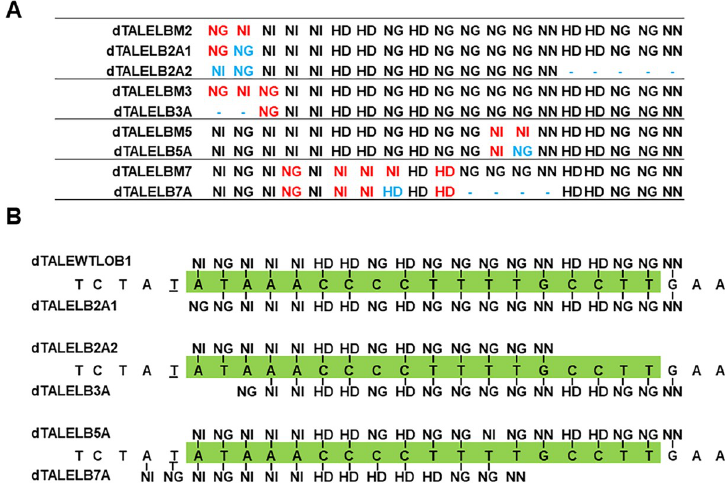
Fig 4. Repeat rearrangements in adapted dTALEs. A. RVD repeat arrays of parental and adapted dTALEs. Red- colored RVDs represent original mismatches compared to dTALEWTLOB1. Blue color indicates deleted or altered repeats in the adapted dTALEs compared to parental dTALEs. B. Predicted binding of adapted dTALEs [determined according to TAL Effector Nucleotide Targeter 2.0 using Target Finder tool (https://tale-nt.cac.cornell.edu/] to the CsLOB1 in sweet orange (Chromosome 7, 28358599–28358574, allelic variant A) EBE. The PthA4 effector-binding element (EBE) is labeled in green and thymidine residue proceeding the EBE is